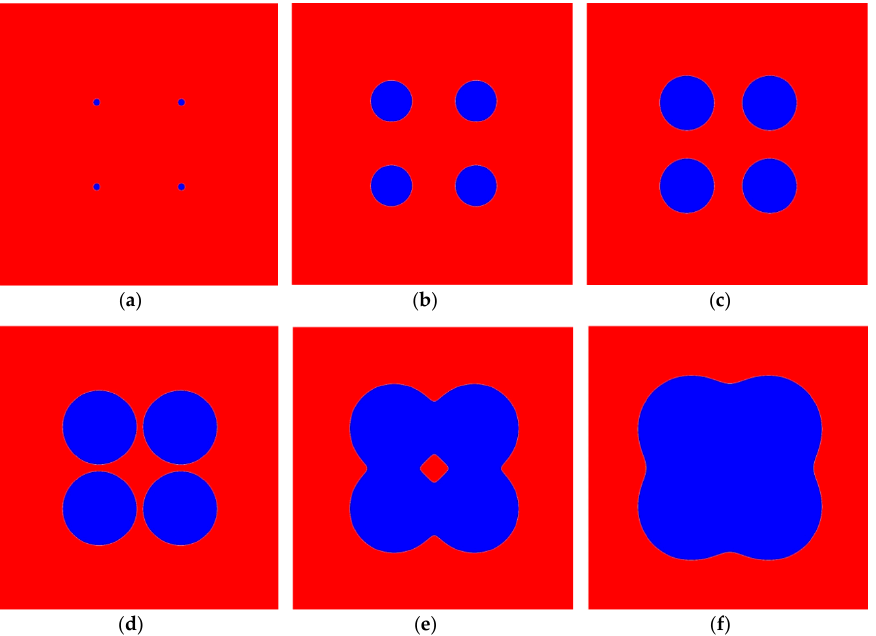
Figure 7. The temporal evolutions of frozen soil wall. ( a ) 0 day; ( b ) 5 day; ( c ) 10 day; ( d ) 20 day; ( e ) 30 day; ( f ) 40 day.